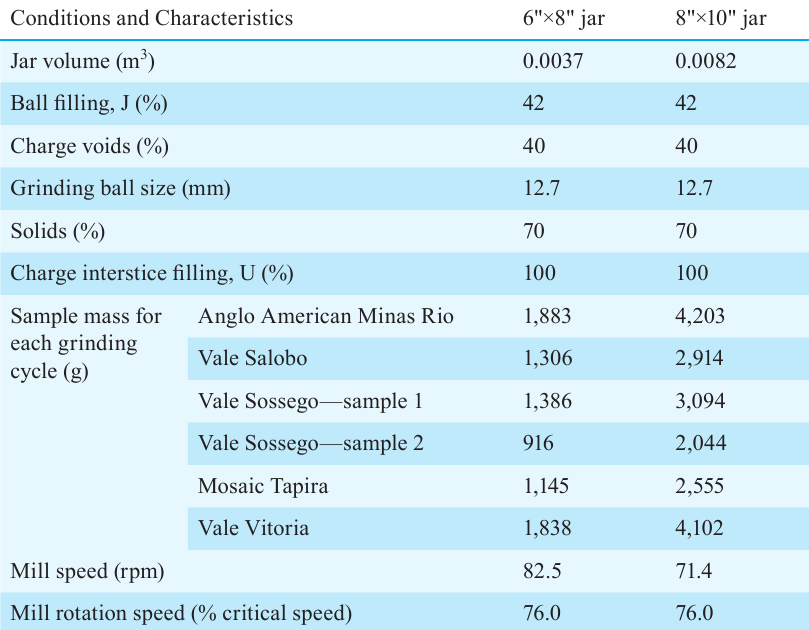
Table 1 Test conditions for each jar